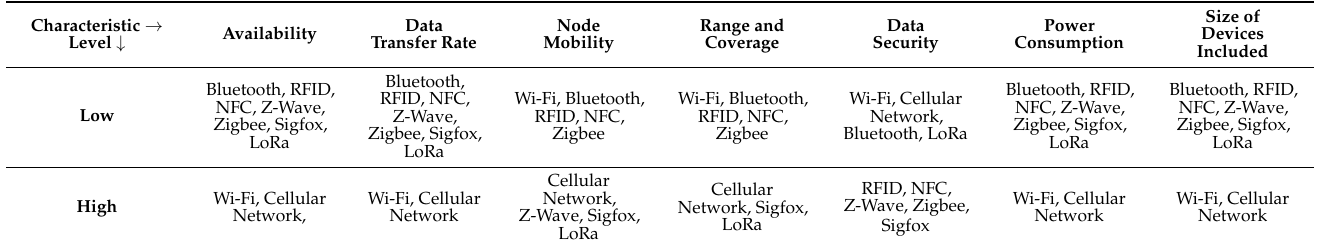
Table 3. IoT technology categorization with respect to its physical